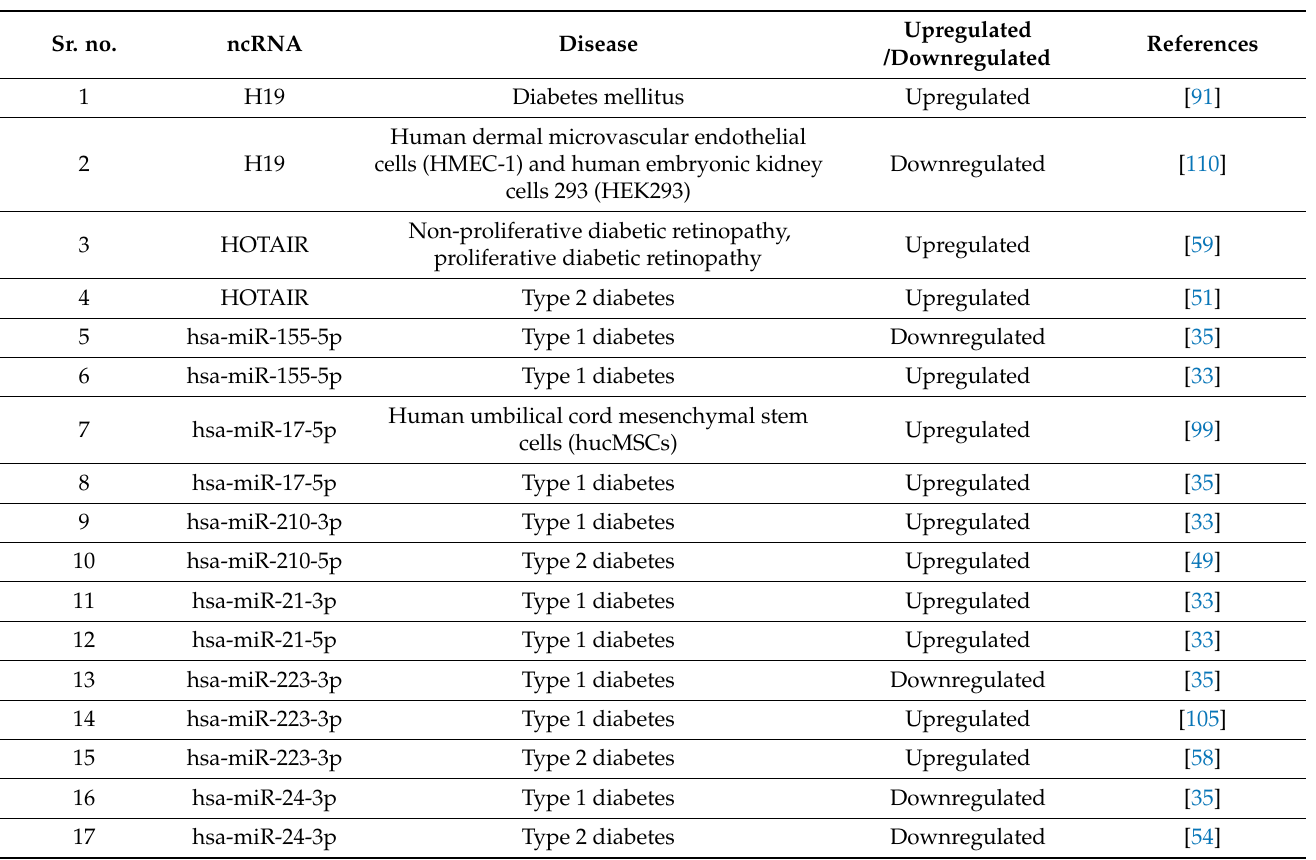
Table 7. Noncoding RNAs as putative markers for